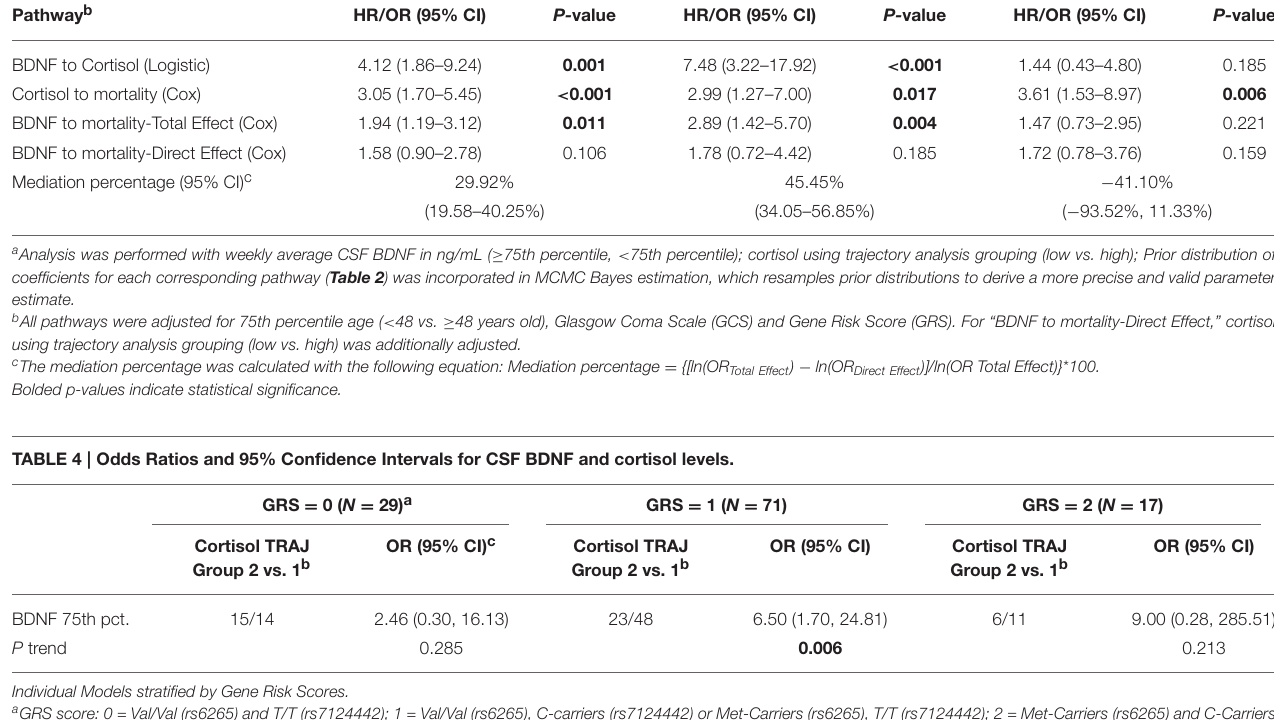
TABLE 3 | Bayes estimation of BDNF and mortality association mediated by cortisol level among all subjects and by 75th percentile of age using Monte Carlo Markov Chain (MCMC) method a . All subjects (N = 117)